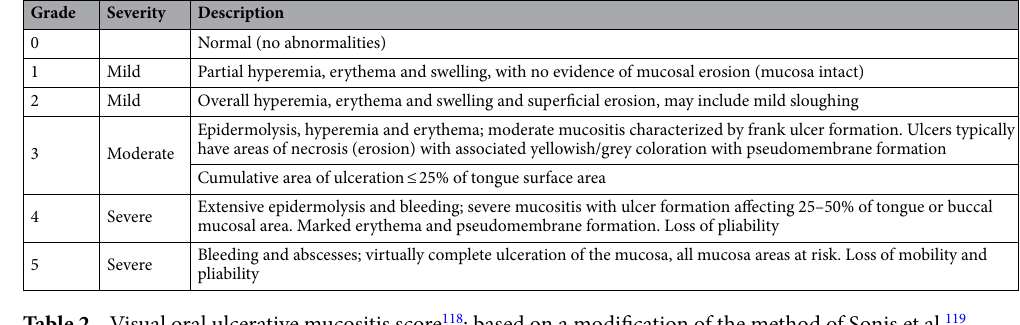
Table 2. Visual oral ulcerative mucositis score 118 : based on a modification of the method of Sonis et al. 119 .